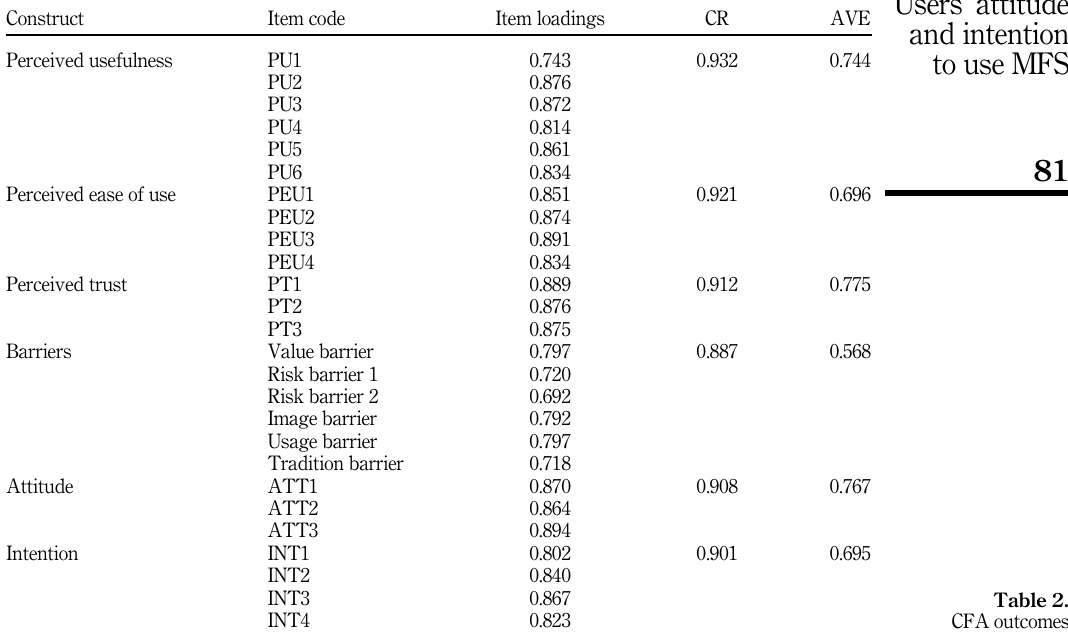
Table 2. CFA outcomes